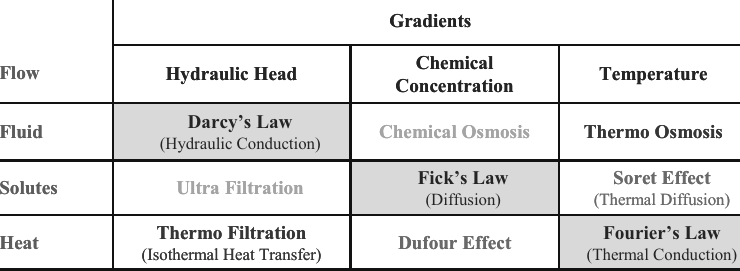
Fig. 11 – Direct and coupled flow processes.